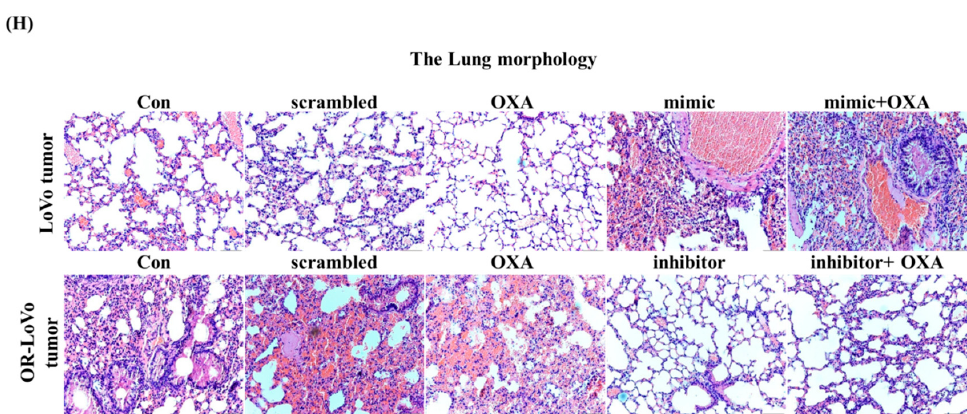
Figure 5. MiR-31-5p or OXA regulates tumor growth and tumor death in LoVo or OR-LoVo tumors in vivo. ( A ) The tumoral growth of LoVo cell xenografted on nude mice in five different groups. Treatment was administered every 3 days from day 0 to 15. ( B ) The tumoral growth of LoVo cell xenografted on nude mice in five different groups. Treatment was administered every 3 days from day 0 to 15. Tumors of LoVo or OR-LoVo cell were subcutaneously implanted. ( C ) Representative pictures of tumoral masses isolated at the moment of sacrifice of mice. The nude mice were sacrificed at day 15. ( D ) Expression of LATS2, p21, and p27 in LoVo and OR-LoVo tumor tissue by Western blotting. ( E ) MiR-31-5p expression in LoVo and OR-LoVo tumor tissue was measured by qRT-PCR. U6 was used as a loading control. Scale bar: 100 µ m ( F ) IHC staining of LATS2 protein in LoVo or OR-LoVo tumor tissue samples. Scale bar: 100 μ m. ( G ) IHC staining of Ki-67 protein in LoVo or OR-LoVo tumor tissue samples. Scale bar: 100 µ m. ( H ) Lung metastasis in mice bearing LoVo and OR-LoVo cells. Upper panel: representative HE-stained sections of lungs from mice with colorectal cancer cell (CRC) metastasis. Scale bar: 100 μ m. * p < 0.05 vs. vs. LoVo cells control group; ** p < 0.01 vs. LoVo cells control group; *** p < 0.001 vs. LoVo cells control group. ## p < 0.01 vs. OR-LoVo cells control group; ### p < 0.001 vs. OR-LoVo cells control group.